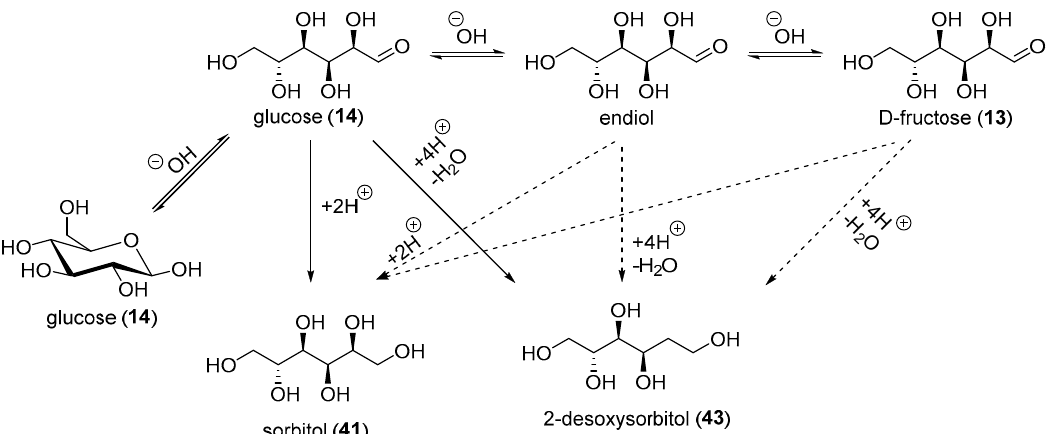
Scheme 22. Proposed mechanism for the direct electro-reduction of glucose.